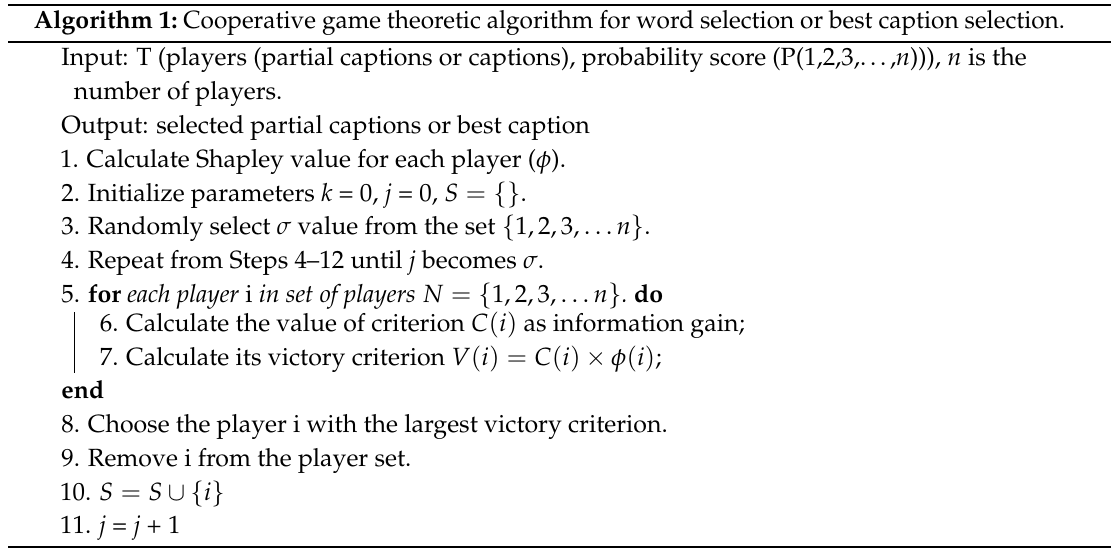
Algorithm 1: Cooperative game theoretic algorithm for word selection or best caption